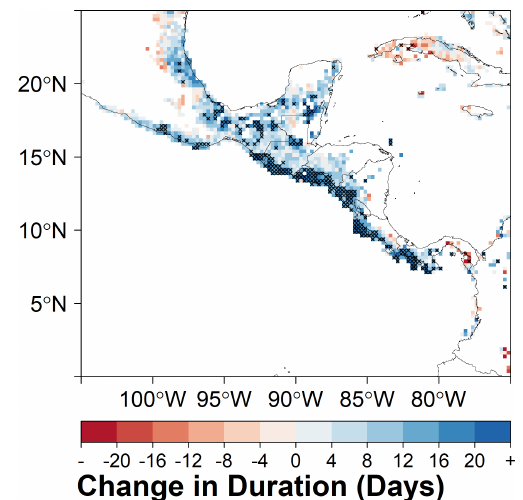
Figure A4. The change in magnitude of the second peak MSD be- tween the early (1981–2000) and late (2001–2020) periods. Grid cells marked with an “X” show statistically significant changes.